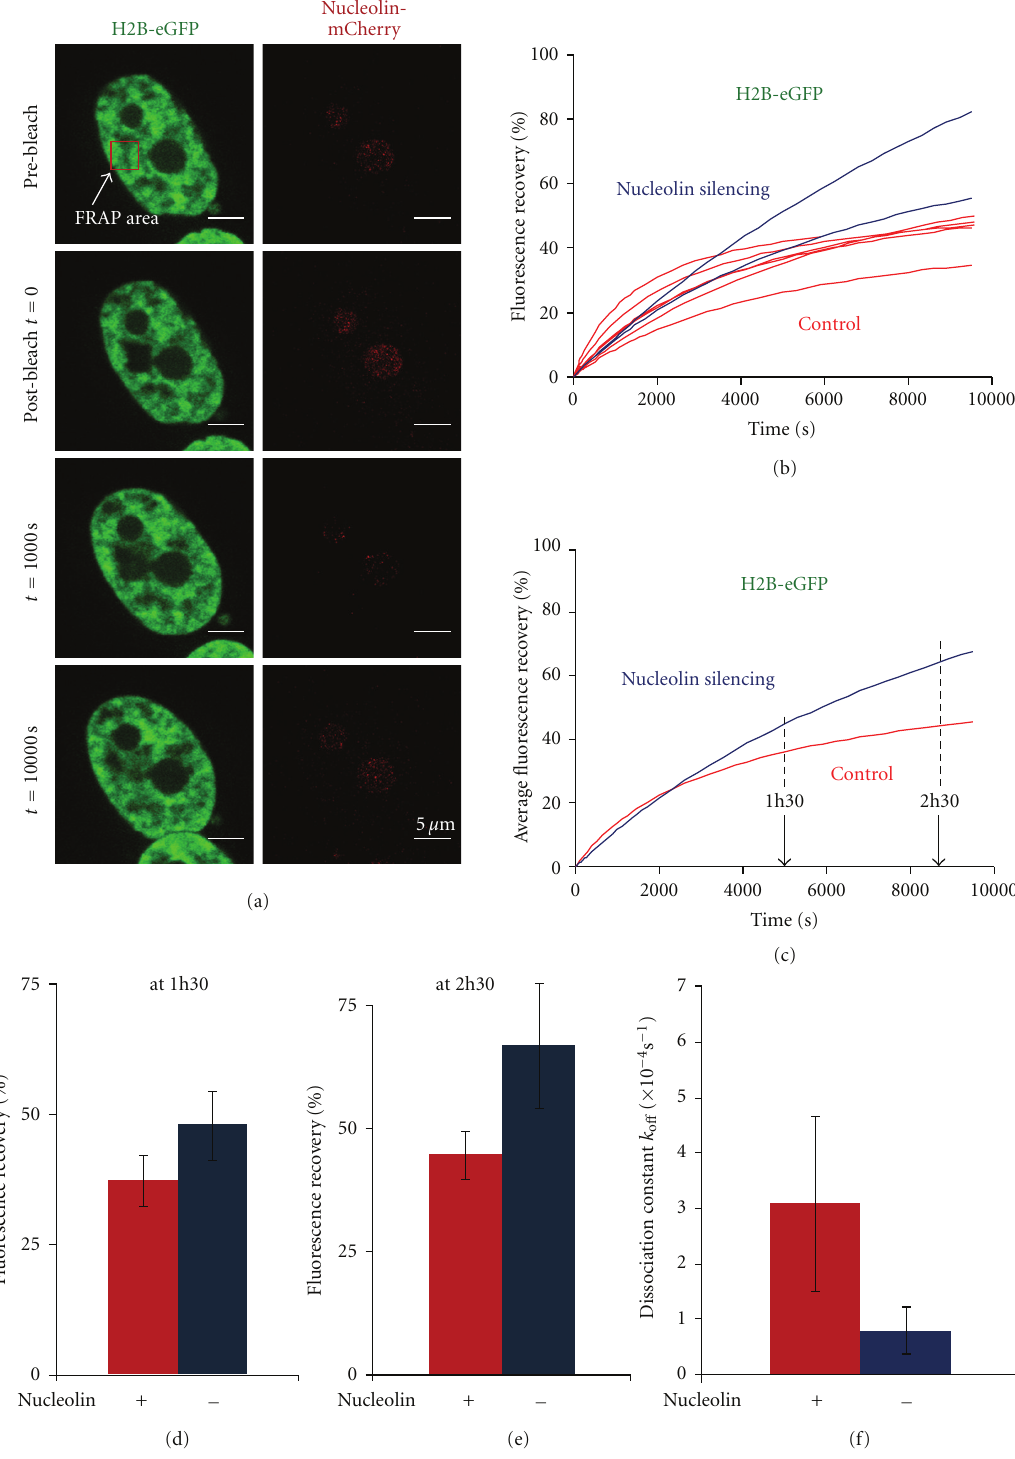
Figure 3: Nucleolin depletion leads to a faster H2B-eGFP fluorescence recovery kinetics. (a) Example of the fluorescence intensity recovery of H2B-eGFP histone in a nucleolin-depleted cell. Scale bars represent 5 μ m. (b) Normalized fluorescence recovery (%) of H2B-eGFP in the nucleoplasm of control-untransfected cells (red, 6 cells) and in cell transfected with siRNA against nucleolin (blue, 2 cells). Each curve represents the fluorescence recovery of a single cell. (c) Average of the normalized fluorescence curves in (b) control cell (red) and nucleolin depleted cells (blue). (d) Comparison of the percentage of fluorescence recovery at 1h30 for control cell (red) and nucleolin-depleted cells (blue). (e) Comparison of the percentage of fluorescence recovery at 2h30 for control cell (red) and nucleolin-depleted cells (blue). (f) Dissociation rate constant values k o ff (s − 1 ) of H2B-eGFP in control-untransfected (red) and nucleolin-depleted cells